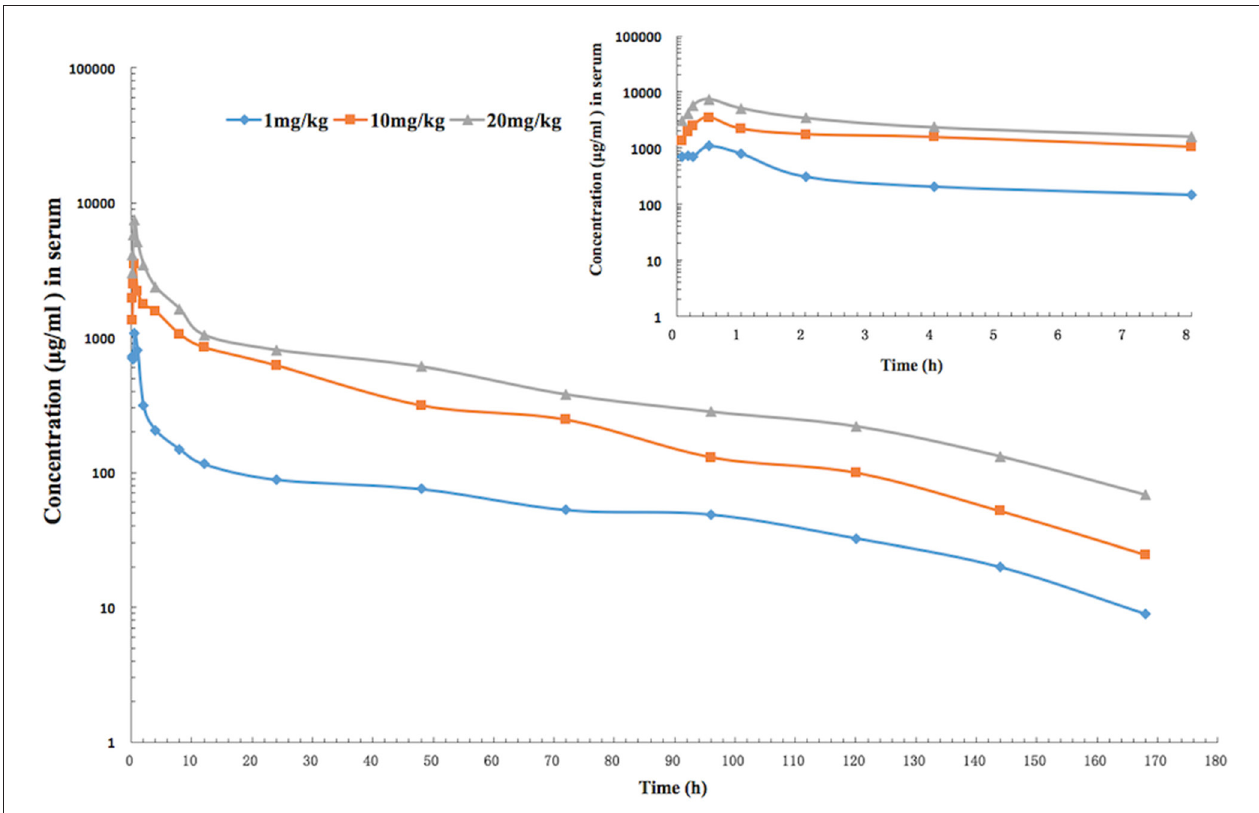
FIGURE 1 | The time-concentration curve of tulathromycin in serum for each of three intramuscular administrations of 1, 10, and 20 mg/kg in a H. parasuis infection model (inset depicts the serum concentrations in the first 8h post-administration; n = 8/time point).